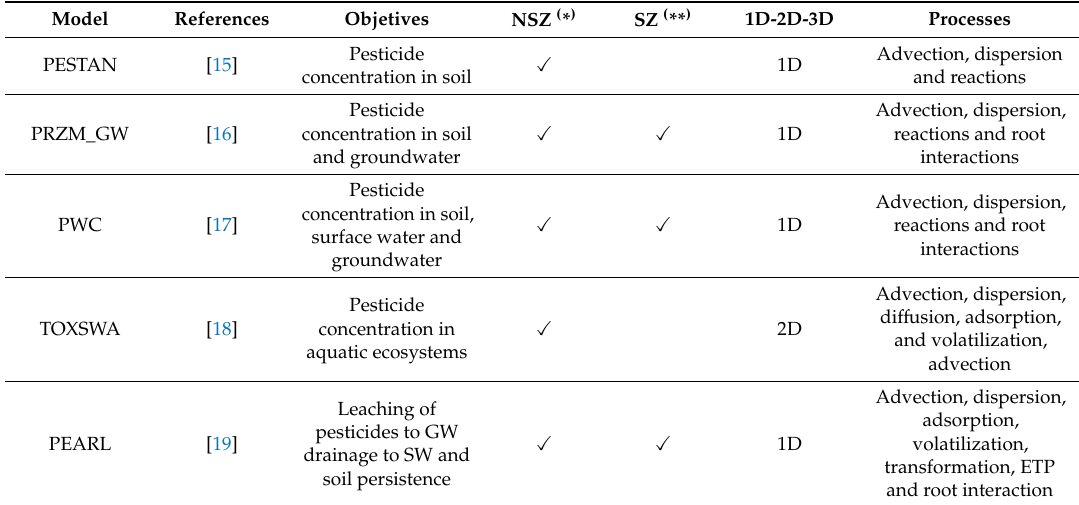
Table 2. Main features of available numerical models for pesticide